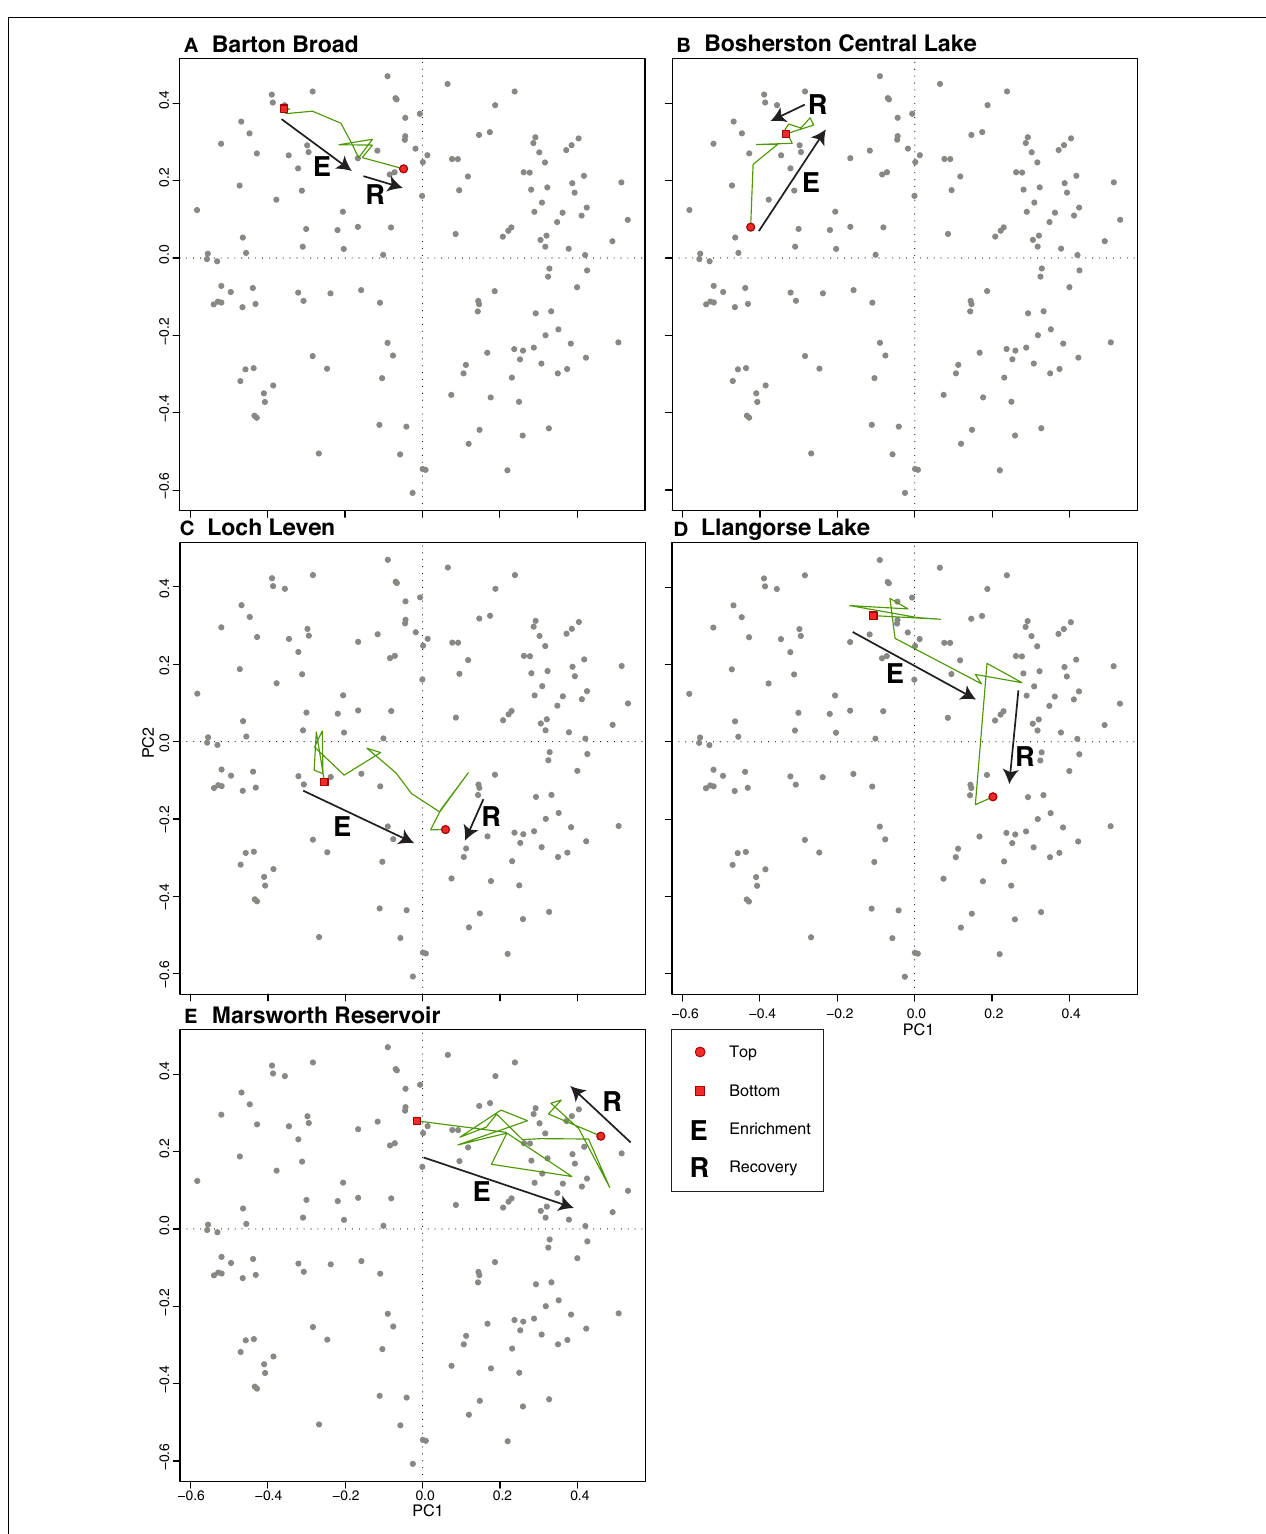
FIGURE 8 | Shallow lake cores plotted passively on a PCA of training set samples. The direction of change over time is shown by the arrows. (A) Barton Broad, (B) Bosherston Central Lake, (C) Loch Leven, (D) Llangorse Lake, (E) Marsworth Reservoir.